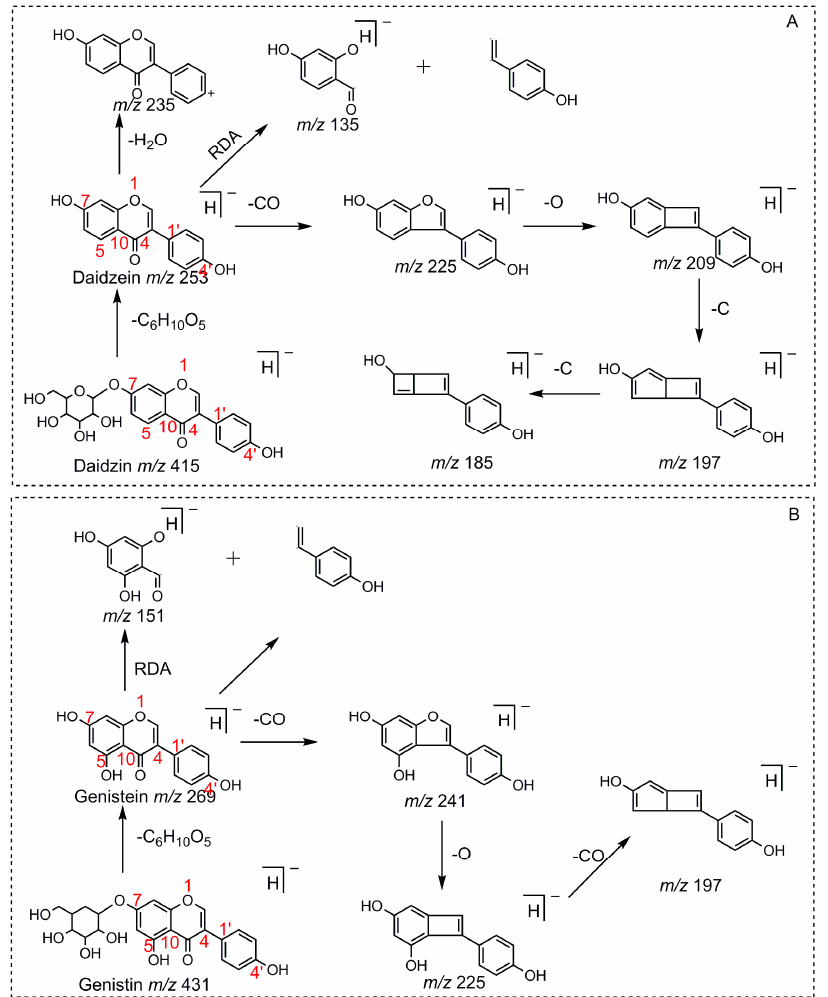
Figure 2. The mass fragmentation behavior of daidzein, daidzein, genistein, and genistin in negative ion mode (( A ) daidzin and daidzein; ( B ) genistin and genistein; Red numbers is location for compound nomenclature).